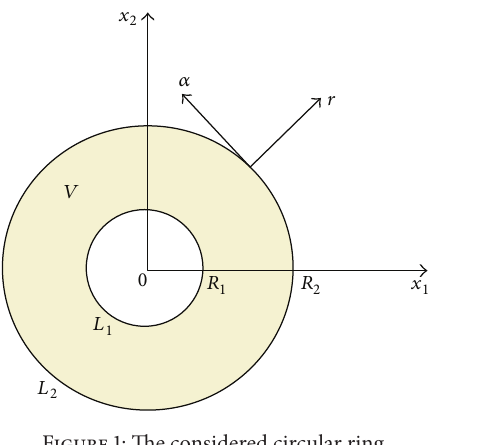
Figure 1: The considered circular